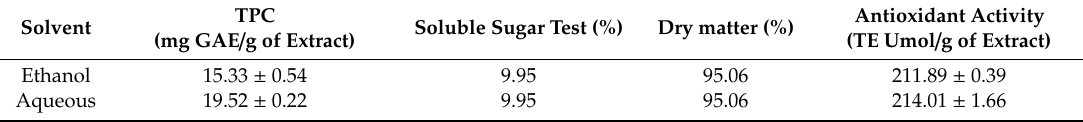
Table 4. Chemical traits of two di ff erent extracts of E. camaldulensis